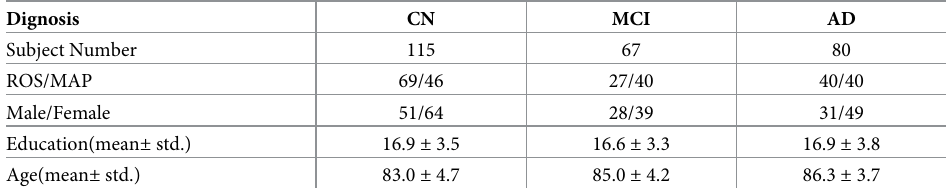
Table 1. Demographic information of the ROS/MAP participants included in this